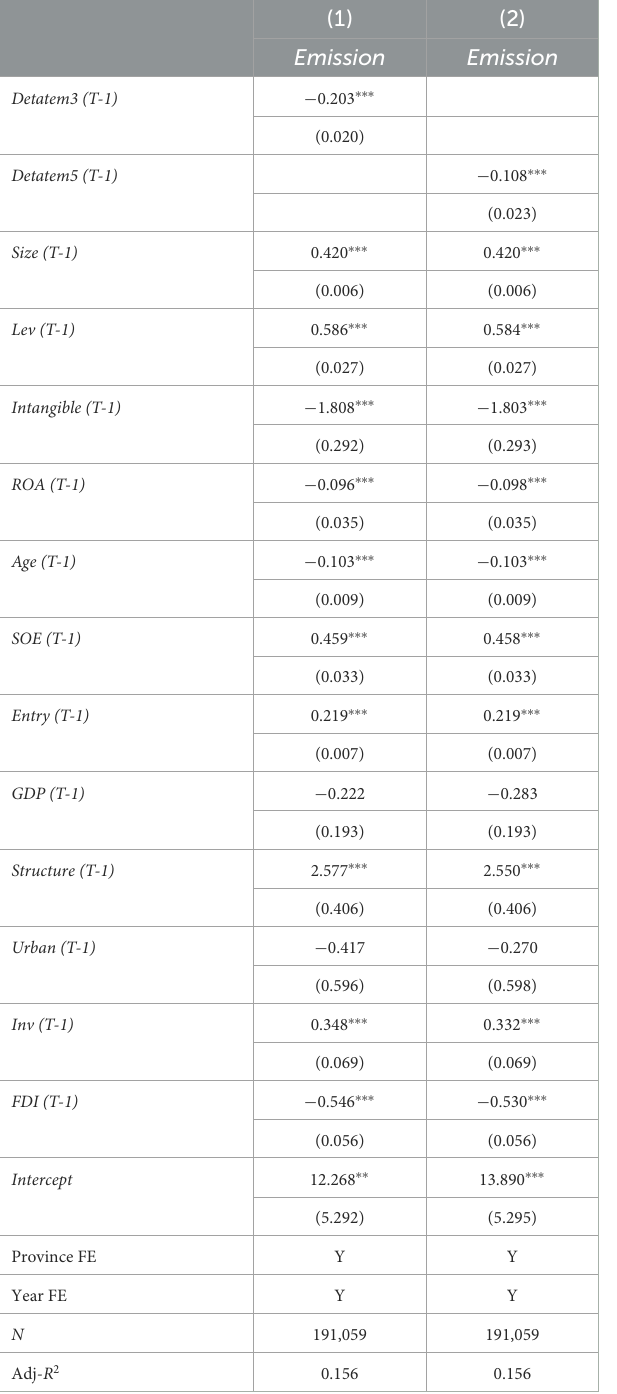
TABLE 6 Change in the time series. TABLE 7 Regression of the change